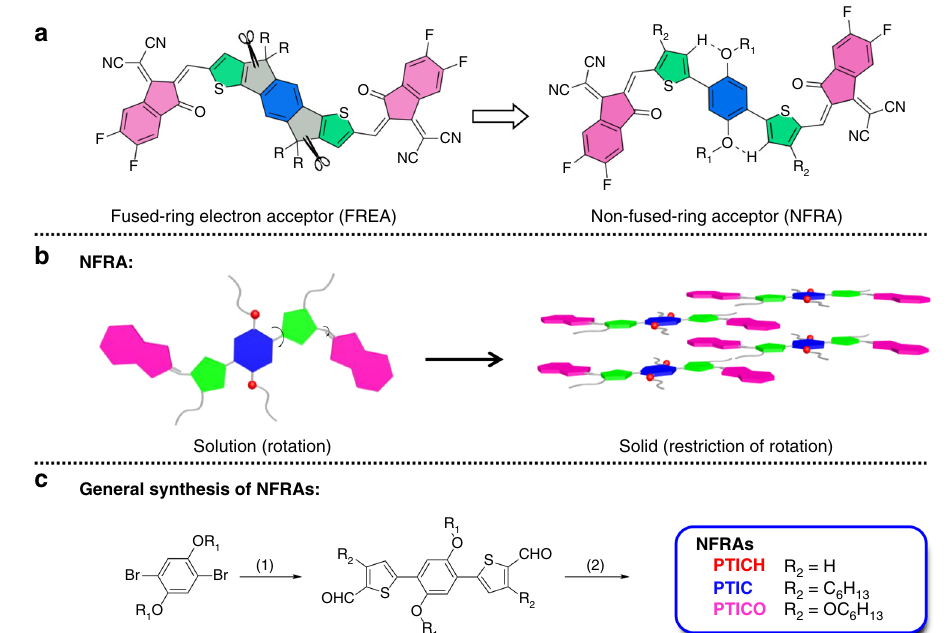
Fig. 1 Non-fused-ring acceptors (NFRAs) and their synthetic route. a The chemical structure of FREA and NFRA. b The schematic presentation of NFRA conformation rearrangement from solution to solid state. c Two-step synthetic route for NFRAs. Here R 1 is 2-hexyldecyl. Reacted condition: (1) 3- substituent-2-thenaldehyde, palladium-catalyzed C – H activation coupling and (2) DFIC, Knoevenagel